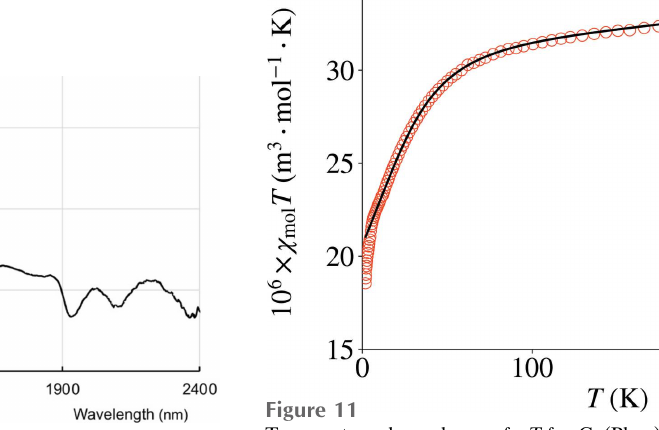
Figure 9 Solid-state Vis–NIR spectrum of [Co(Ppz)Cl]ClO 4 .